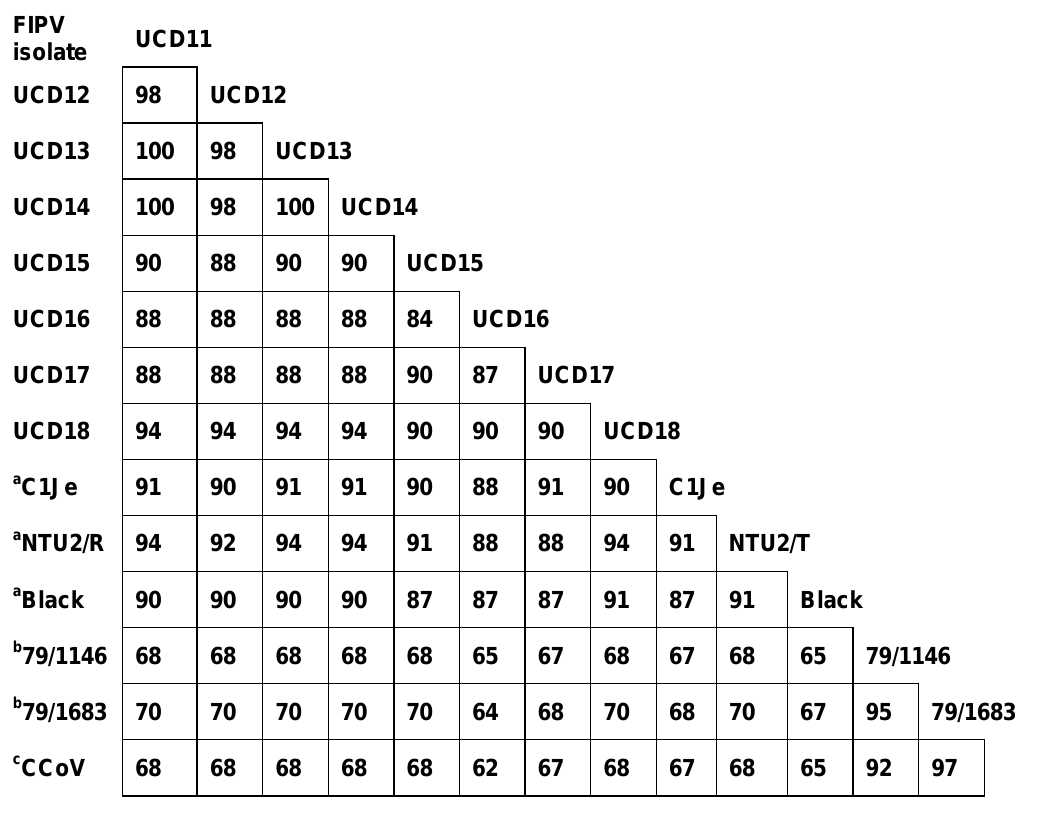
Figure 3. A comparison of the amino acid sequences of 3a proteins from several different FIPVs and a canine coronavirus (CCoV). The reference sequence is from FIPV-UCD11. GenBank accession numbers for additional FIPV isolates are EU186072(Black), DQ160294(NTU2/R), DQ848678(C1Je), NC_007025(WSU-79/1146), X80799(WSU- 79/1683), and